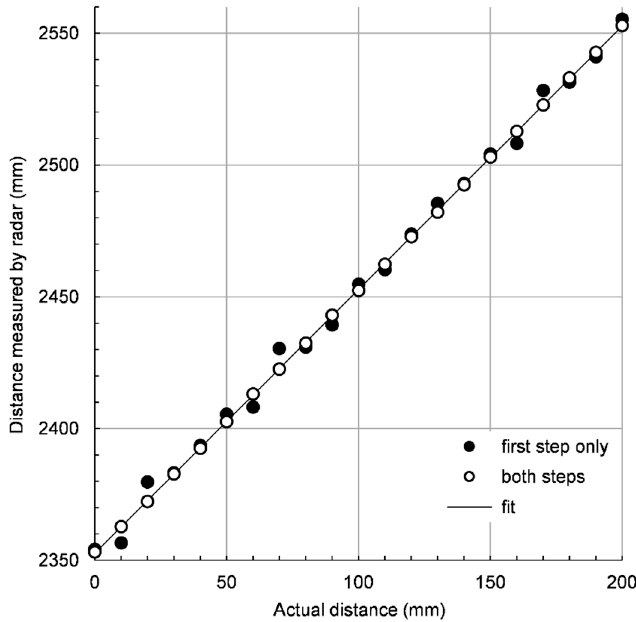
Figure 5. Distance measured by the radar versus actual target displacement distance. After applying the second step of the algorithm, the errors become too small to see in this plot.